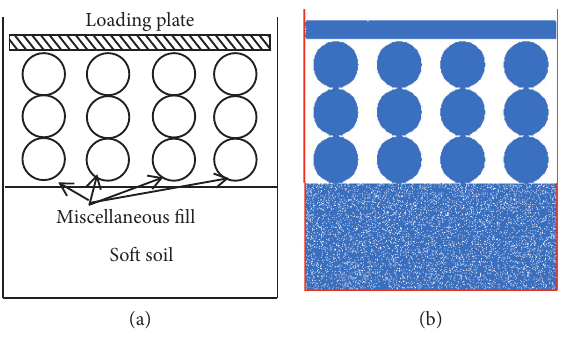
Figure 3: Structure of the